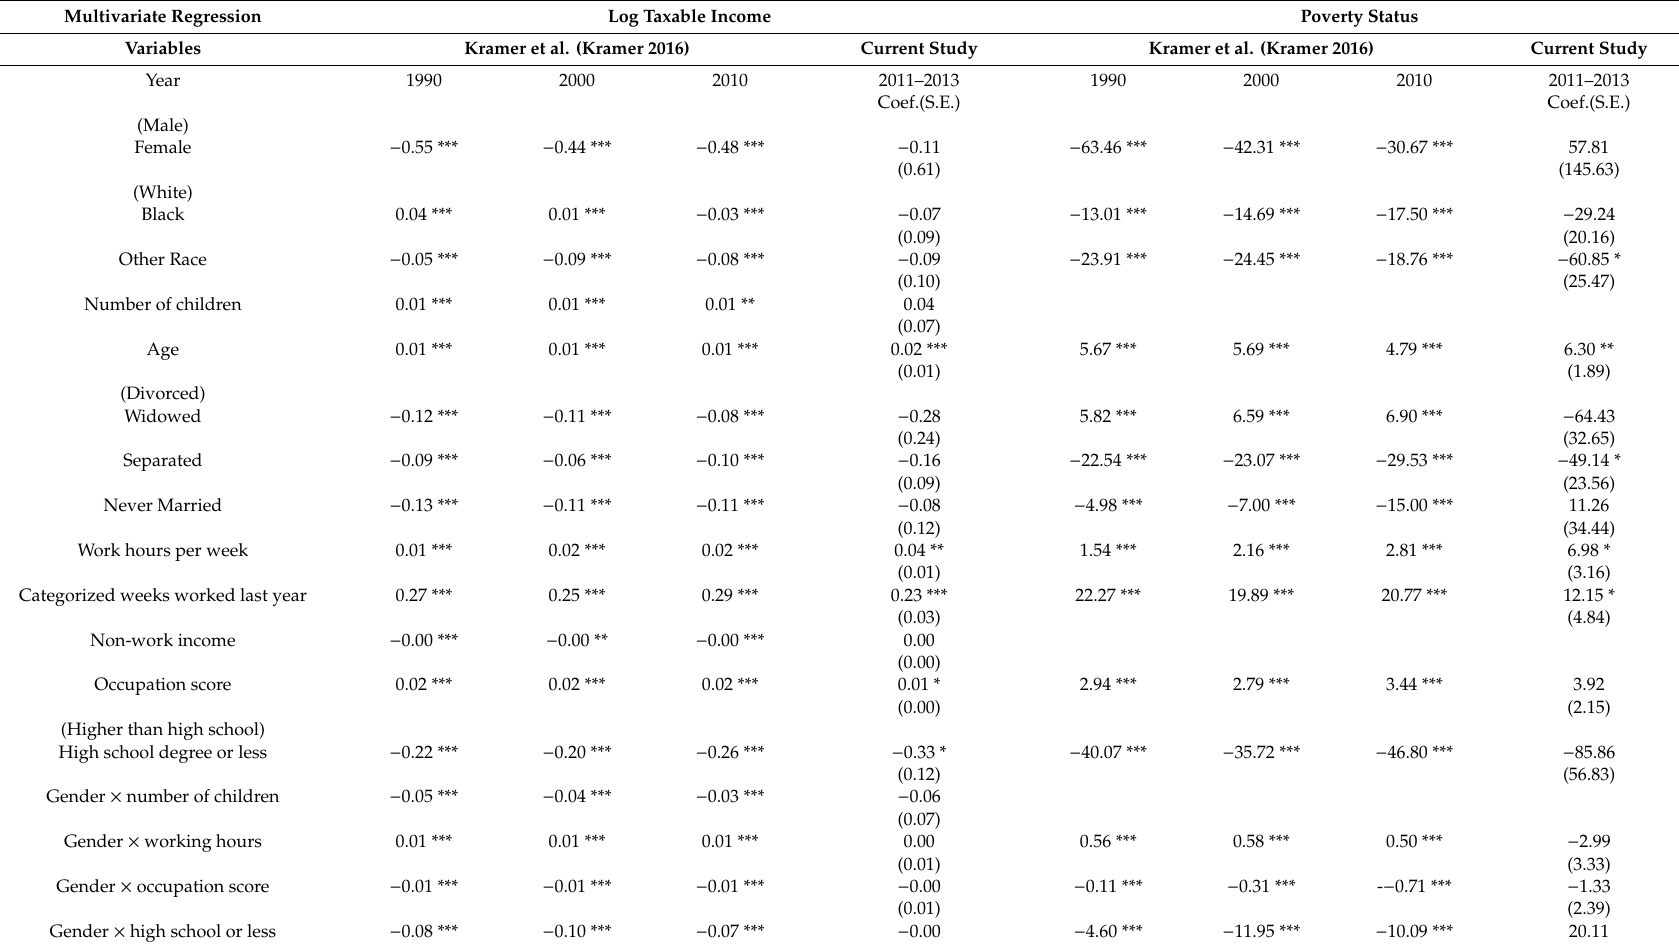
Table 2. Comparison of multivariate regression coe ffi cients of independent variables predicting log taxable income and poverty status between Kramer et al. [1] and the current study (full